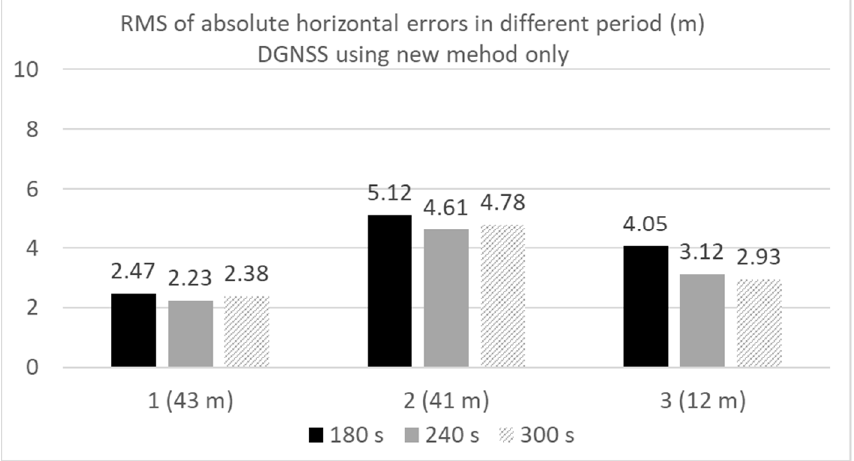
Figure 23. Comparison of RTK-GNSS correct fix rates in three locations.